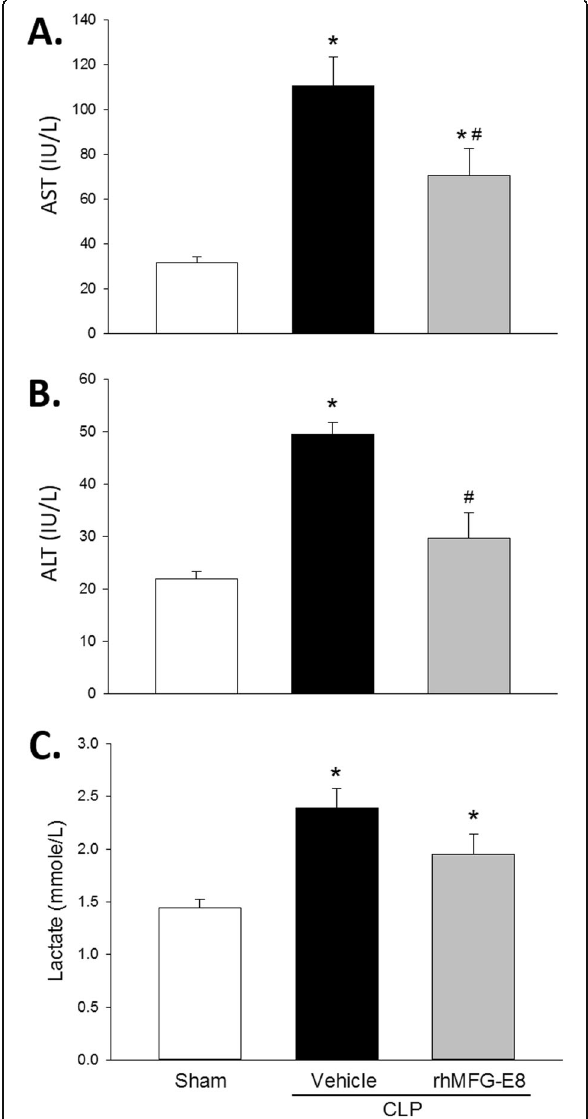
Fig. 3 rhMFG-E8 attenuates organ injury and hypoxia in CLP after acute alcohol exposure. Serum levels of ( a ) AST, b ALT, and ( c ) lactate were increased rats subjected to CLP and treated with vehicle (human albumin) compared with sham surgery, and lower in rats subjected to CLP and treated with rhMFG-E8. Prior to CLP, all rats were exposed to acute alcohol intoxication; means + SE; n = 10 – 14 for sham and n = 9 for other experimental groups; ANOVA plus Student- Newman-Keuls method, * P < 0.05 vs. Sham, # P < 0.05 vs. group. These findings suggest that rhMFG-E8 is able to reduce acute lung injury in rats with sepsis after acute alcohol exposure. rhMFG-E8 reduces the number of apoptotic cells in tissues in CLP associated with acute alcohol exposure MFG-E8 is known to facilitate the clearance of apoptotic cells by efferocytosis and, thus, decreases the number of